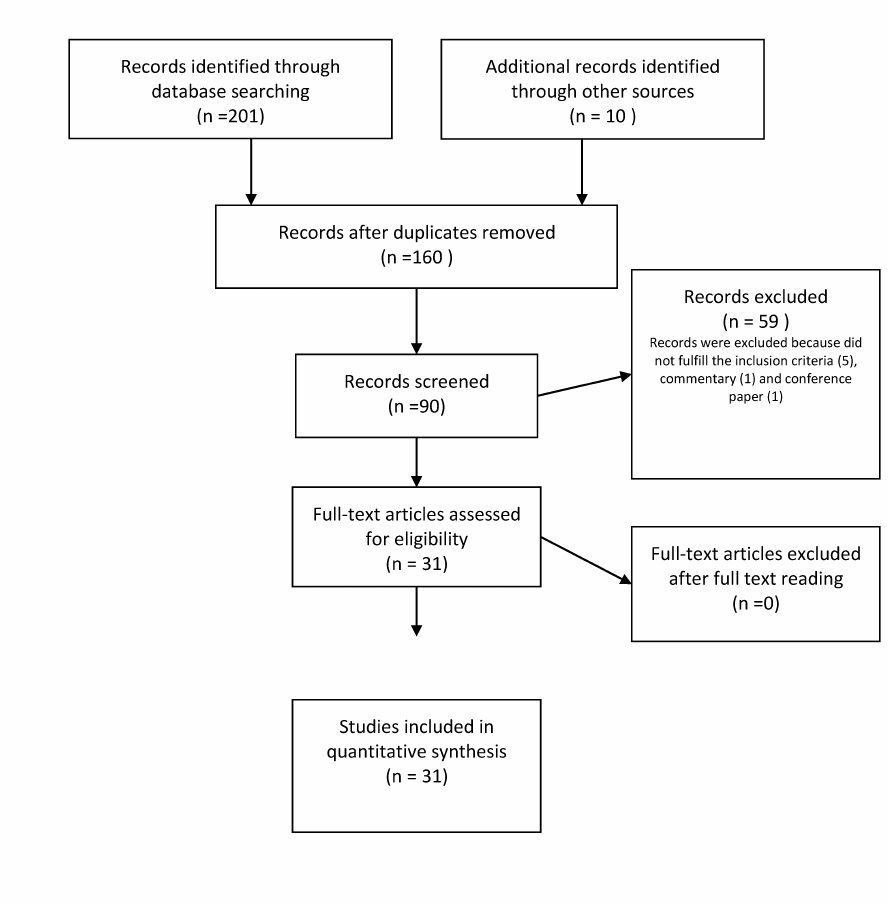
Figure 2. PRISMA flow diagram of study selection process.